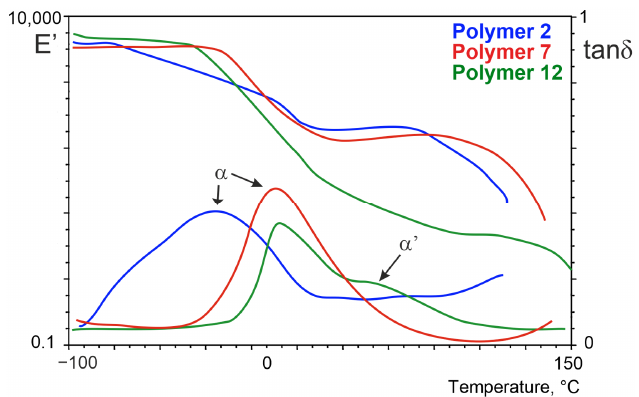
Figure 11. Dynamic Mechanical Thermal Analysis (DMTA) for the terpolymers with 3GT ester block; molar ratio: PTMO/PA12 = 3 (polymer 2), DLAol/PA12 = 3 (polymer 7), DLAol/PA12 = 5.5 (polymer 12).